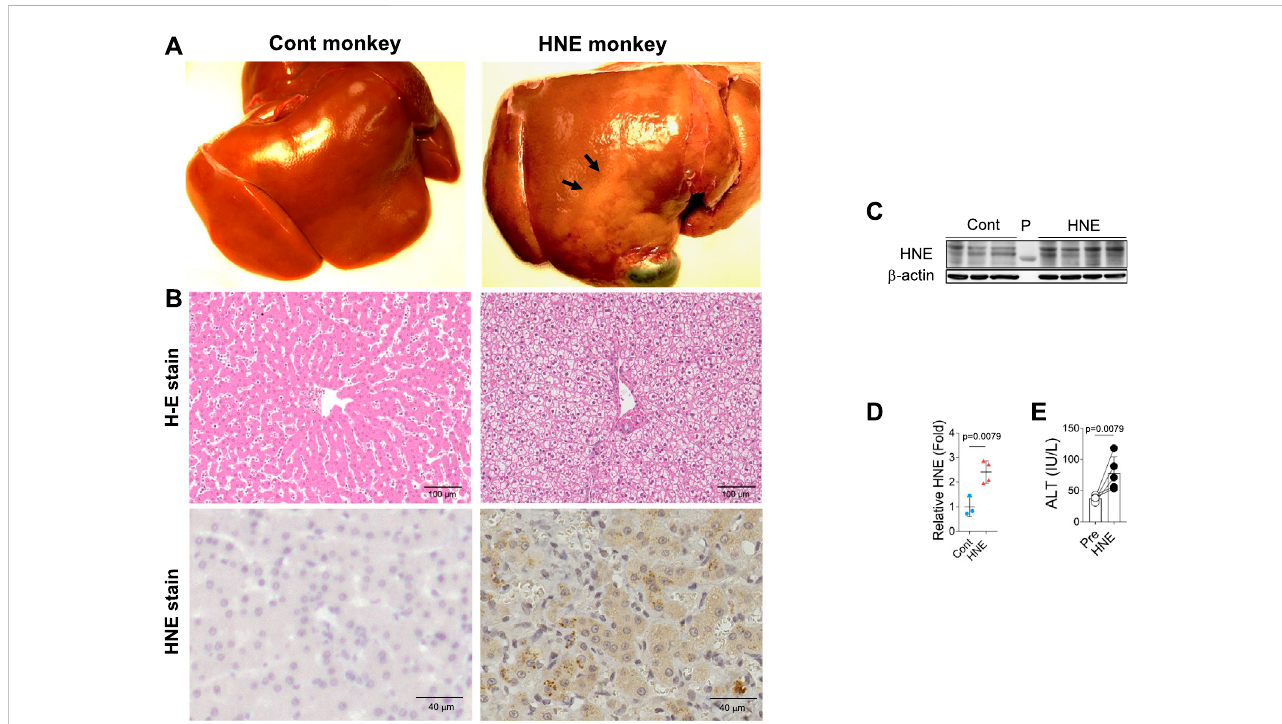
Hydroxynonenal (HNE) induces liver injury in the Japanese macaque monkeys. Panel (A) Macroscopic fi ndings of livers of the control (Cont) and HNE- treated(HNE)monkeys.Blackarrowsshownodulardiscoloration.Panel (B) H-EstainingandHNEimmunostainingoflivertissuefromthecontrolgroup(Cont) and HNE-treated (HNE) group. HNE immunoreactivity was negligible in the control hepatocytes, but was distinct in the latter hepatocytes. Panel (C) Western blottinganalysesoftheliverHNEproteinadducts inthecontrol(Cont)andHNE-treated(HNE)group.P,proteinmarker.Panel (D) Bandsofpanel C